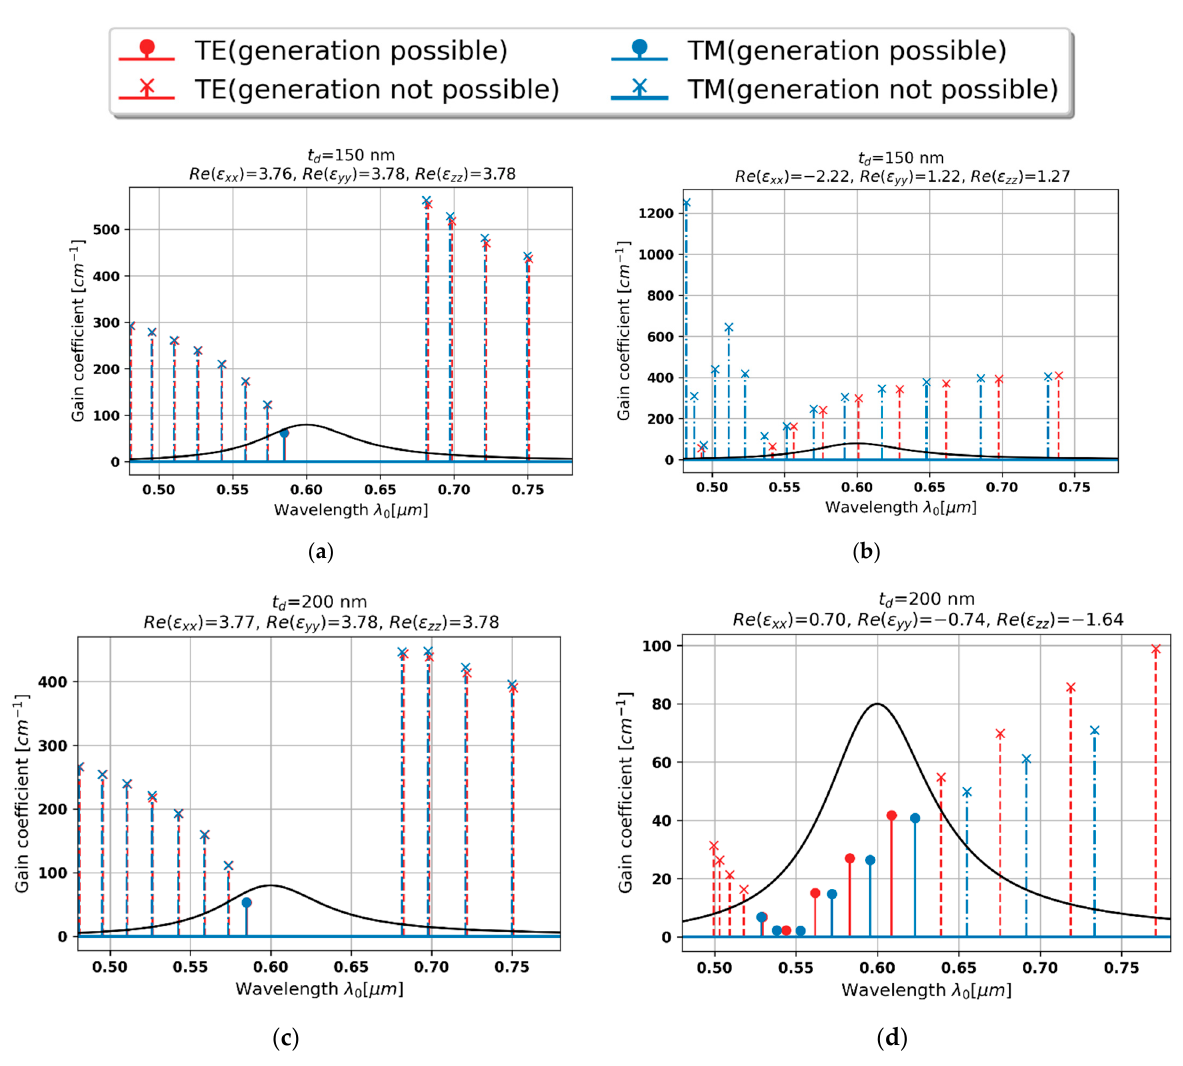
Figure 10. Local ( a , c ) and nonlocal generation spectra ( b , d ) for PHC lasers based on various dielectric layer thicknesses t d = 150 ( a , b ) and 200 nm ( c , d ).